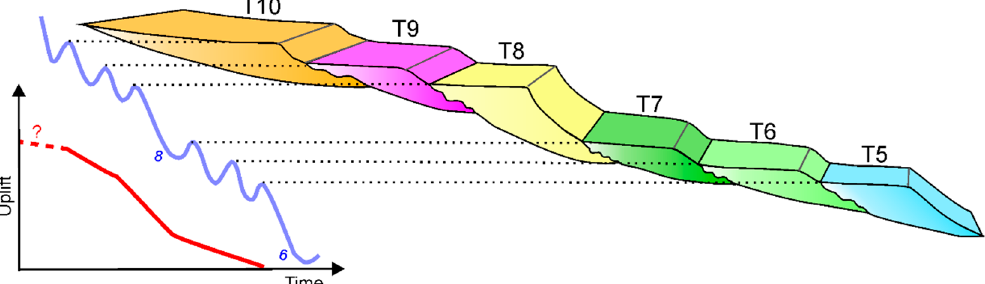
Figure 8. Sketch of terrace spacing resulting from the interaction between sea level curve (simplified blue line) and uplift variation over time (red line). Blue numbers in italics indicate marine isotopic stages. Terrace colors are the same as those in Figure 2. It is noteworthy that the figure is not to scale.